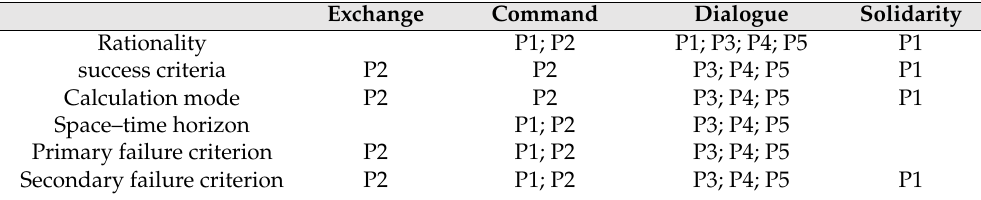
Table 2. Governance modes according to Jessop applied to the interactions led by the Universidad Externado de Colombia with its closest environment and the eastern